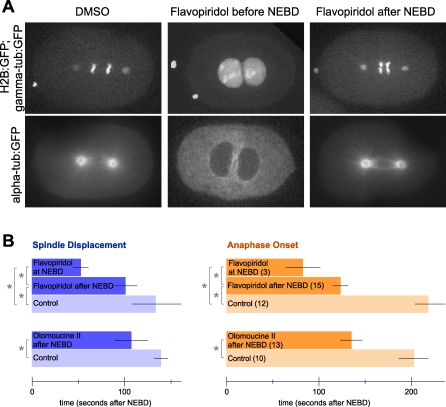
Premature CDK Inactivation Results in Premature Spindle Displacement(A) Embryos expressing histone H2B:GFP and gamma-tubulin:GFP, or expressing alpha-tubulin:GFP, were laser-permeabilized. Embryos permeabilized in DMSO proceeded through mitosis similar to wild-type, and had normal spindle morphology. When embryos were treated with flavopiridol prior to mitosis, they did not undergo NEBD (11/12 H2B:GFP- and gamma-tubulin:GFP-labeled embryos), nor did they maintain centrosome-nucleated microtubules (8/9 alpha-tubulin:GFP-labeled embryos). Embryos treated with flavopiridol later in mitosis proceeded through mitosis with premature anaphase (below), and with normal spindle morphology (8/8 alpha-tubulin:GFP-labeled embryos).(B) Flavopiridol treatment at the start of or after NEBD, or olomoucine II treatment after NEBD, caused spindle displacement and anaphase onset to occur earlier than in wild-type. Controls are laser-permeabilized embryos in DMSO. Flavopiridol-treated embryos were examined to determine if the treatment specifically shortened the times to spindle displacement and anaphase onset, and not speed up cell cycle timing more generally: Treatment did not shorten the interval from anaphase to cytokinesis (n = 19 embryos for wild-type control, n = 4 embryos for flavopiridol). Error bars represent the 95% confidence intervals for significance, and asterisks represent statistical significance at p < 0.05. Number of cases analyzed for each experiment is indicated in parentheses on the anaphase onset bars. For statistical values, see Methods.